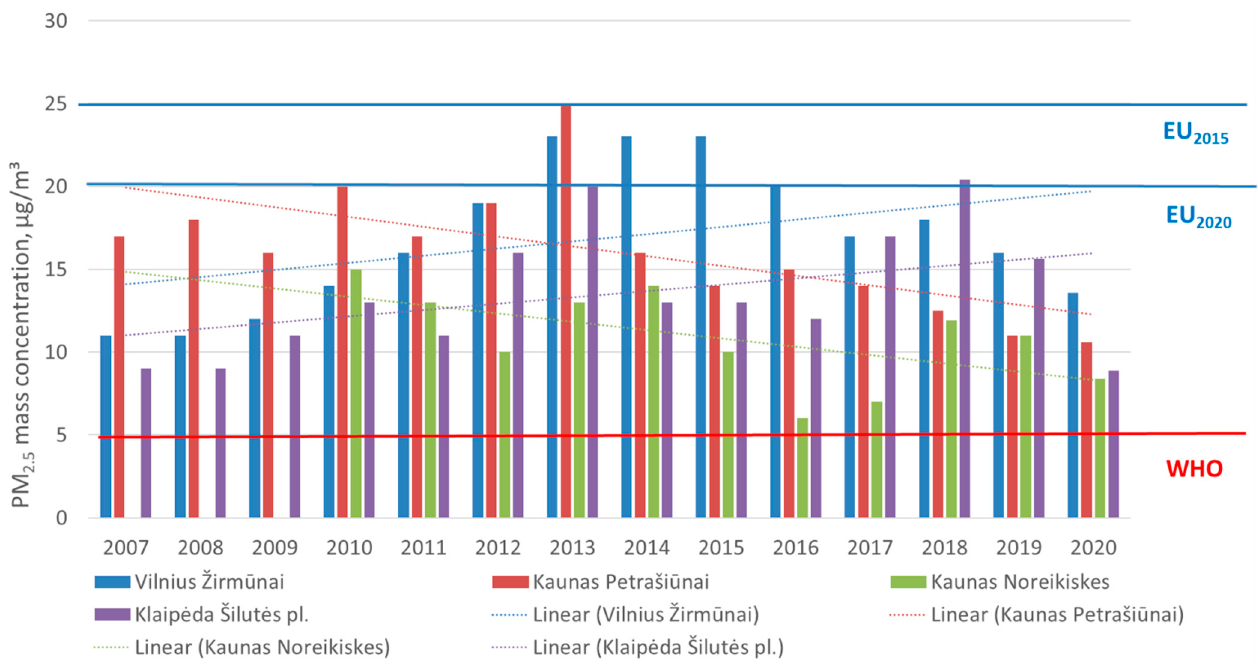
Figure 8. Annual mean PM 2.5 concentration and trends in biggest cities.